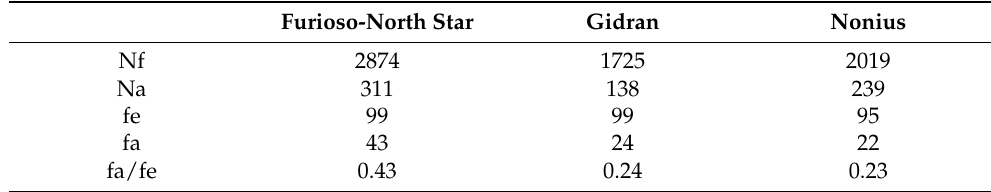
Table 3. Founders and ancestors in the reference populations.